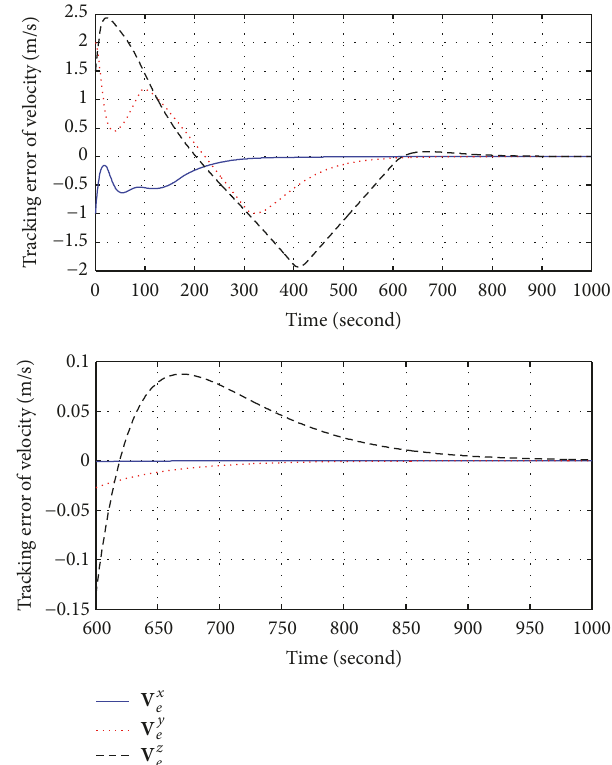
Figure 5: Tracking error of the velocity of